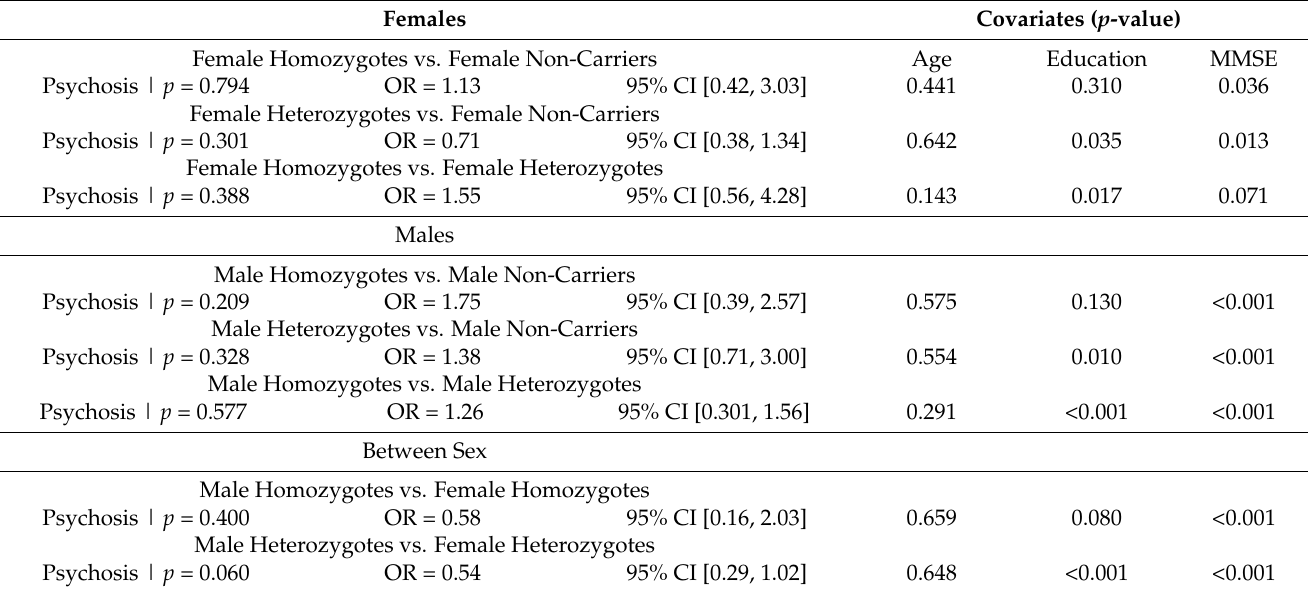
Table 3. LB ( − ) Cohort,